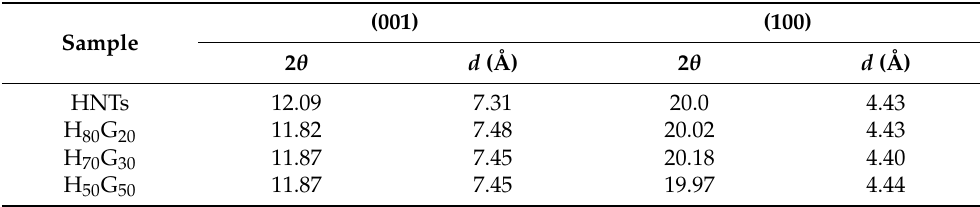
Table 2. Diffraction peaks (2 θ ) and corresponding interlayer distance ( d ) for neat HNTs and all nano-hybrids.